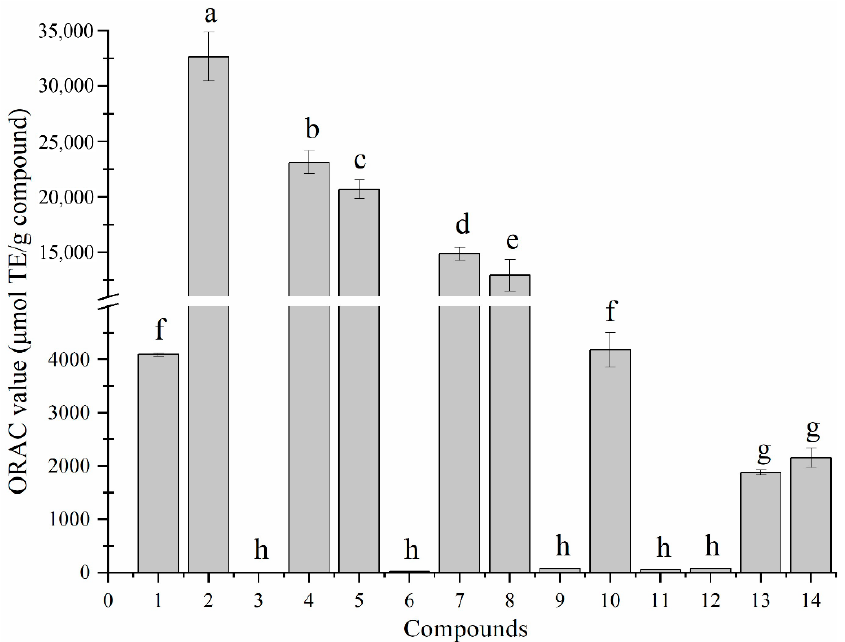
Figure 2. The ORAC values of compounds 1 – 14 (mean ± SD, n = 3). Bars marked with different letters mean significant difference at p < 0.05 between each other.